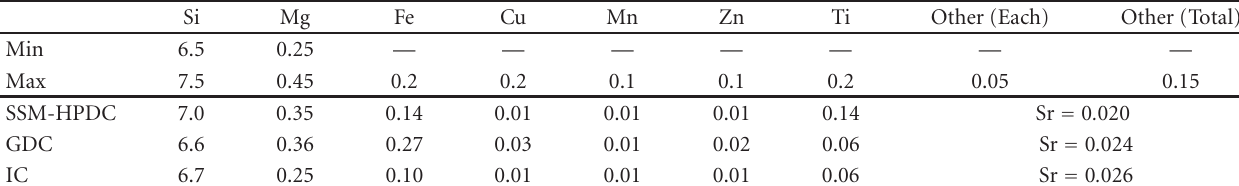
Table 1: Chemical composition limits for alloy A356 [6], as well as the compositions of the alloys used in this study.